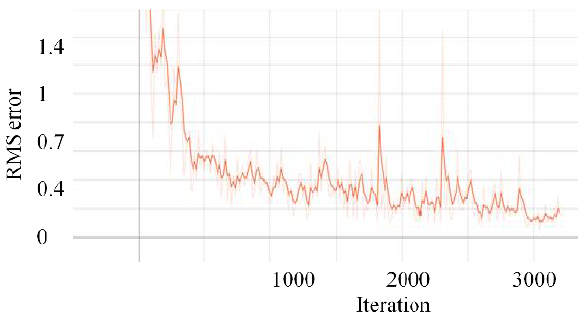
Figure 10. Loss function minimization using the gradient descent Algorithm 1 over number of steps.